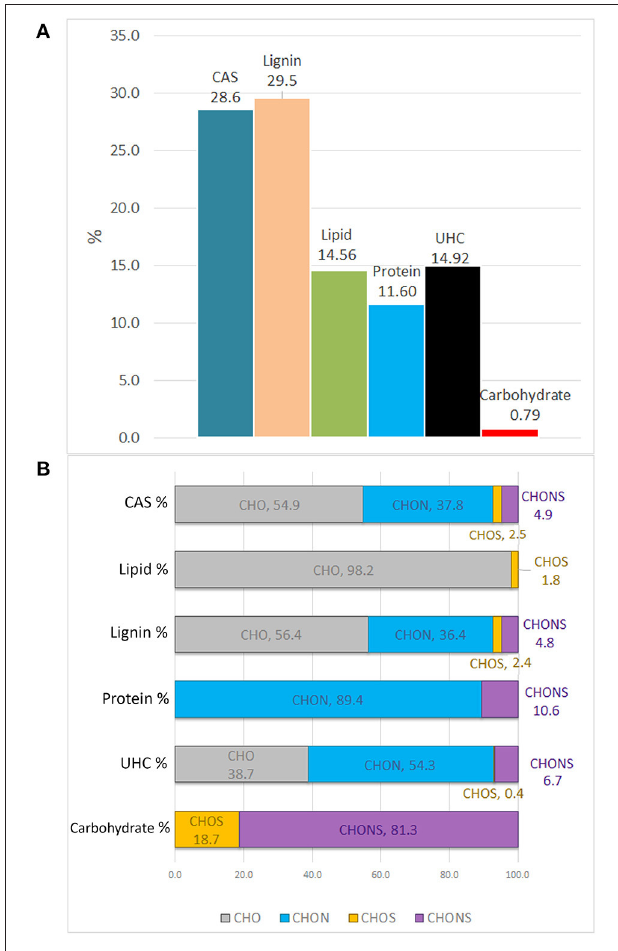
FIGURE 3 | Van Krevelen proportion of different organic compound classes expressed in percentage, as calculated by H/C and O/C ratios (A) . Contribution of heteroatoms groups to each compound class (B)